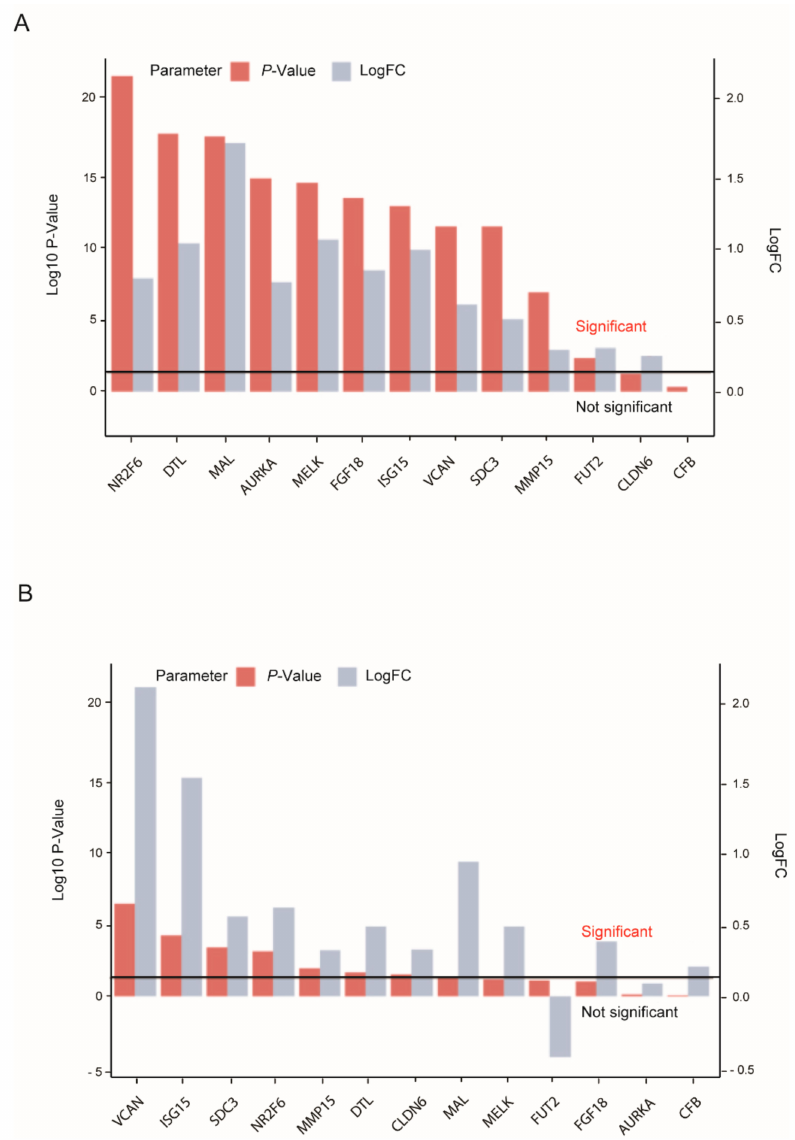
Figure 4. Reported biomarker expression. Log–Fold change of biomarker candidates are shown for two sets of cohorts; ( A ) healthy ovarian surface epithelium (OSE) versus ovarian cancer (OVCA) and ( B ) healthy versus cancerous stromal tissue. P -values higher than 1.3 are significant (horizontal line). Genes have been ranked according to their P -values in the OSE versus OVCA comparison from highest to lowest statistical power. Data have been procured from the CSIOVDB database [39]. Both plots show the same genes but are di ff erently ordered by increasing the P -value. Di ff erentially expressed biomarker candidates that distinguish malignant from healthy tissues are clearly present in plot A. By comparison, significantly fewer biomarkers that distinguish malignant from benign tissue are identifiable on plot B. In particular, the P -values for di ff erential expression are significantly higher on plot B, although VCAN, ISG15, and MAL show a comparable Log–Fold change, which indicates a higher variance, i.e., expression heterogeneity within the